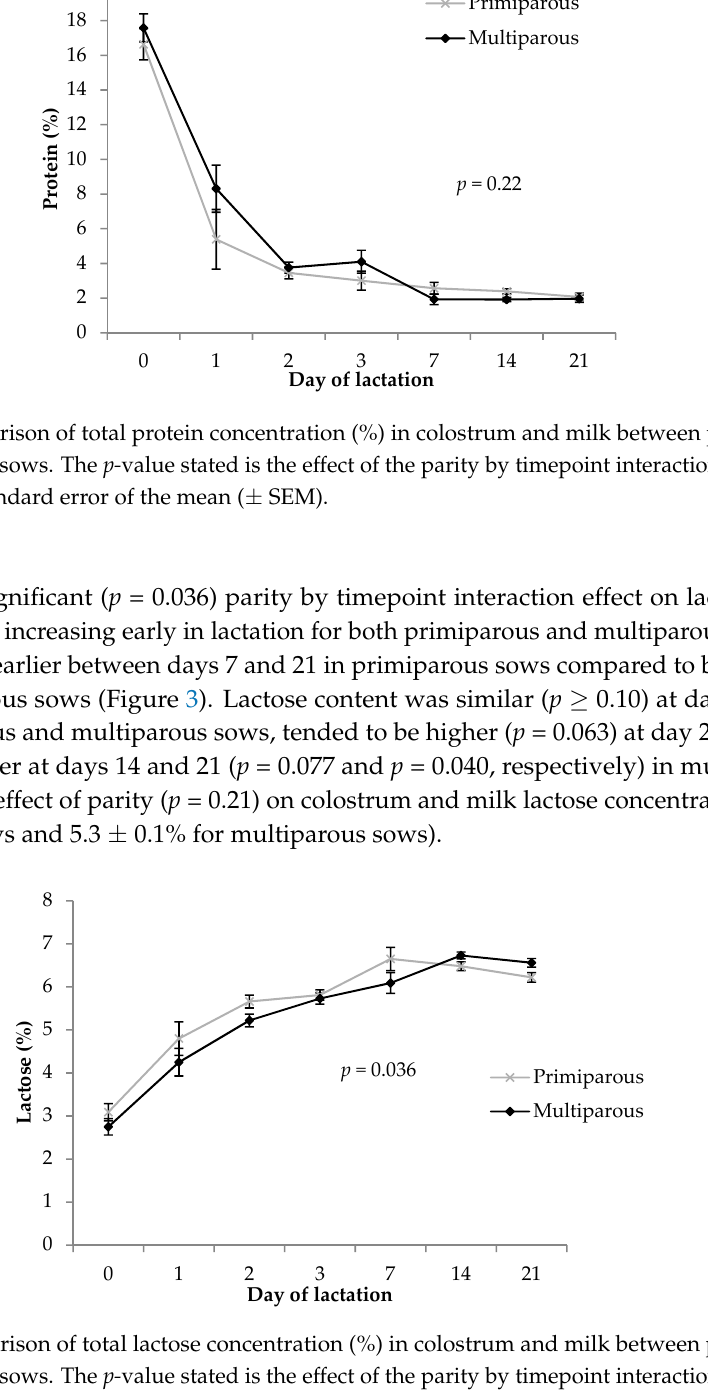
Figure 1. Comparison of total IgG concentration (g/L) between primiparous and multiparous sows in: ( a ) colostrum and transient milk (days 0 to 3); and ( b ) milk in later stages of lactation (days 7 to 21). Error bars represent the standard error of the mean (± SEM).